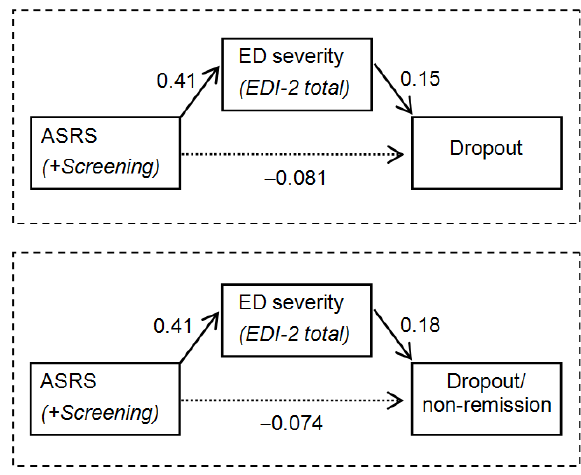
Figure 3. Path-diagrams: standardized coefficients in the SEM for the short-term therapy outcome ( n = 136). Continuous line: significant coefficient. Dash line: non-significant coefficient. Results adjusted by age and duration of the ED.